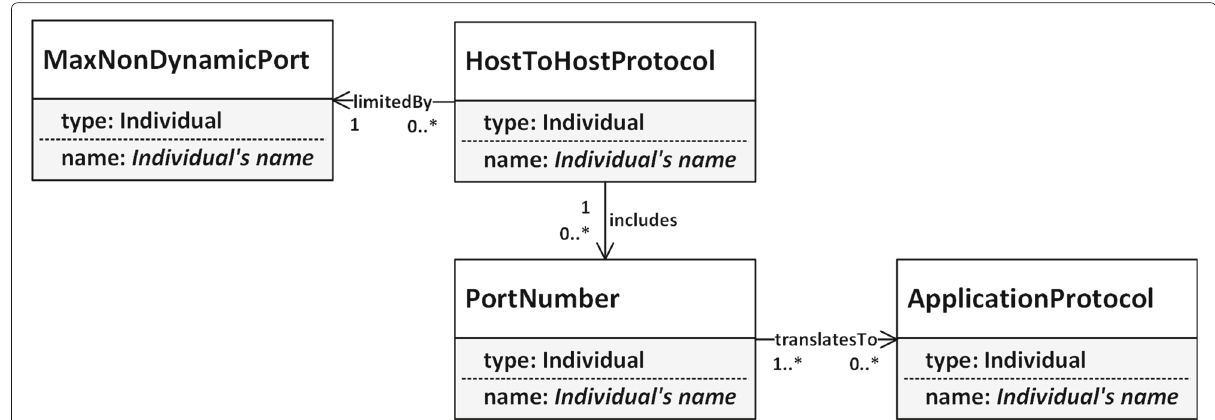
Fig. 8 Grouping of data